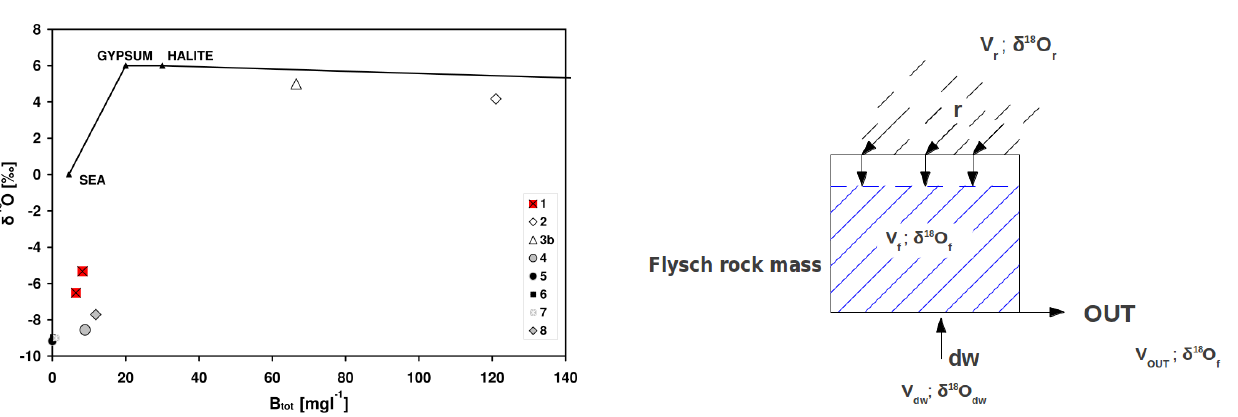
Fig. 9. B tot - δ 18 O diagram. Point: 2, 4 (Boschetti et al., 2010) – baths; 3b – mud volcanoes; 5 – common shallow groundwater; 6 (Cervi, 2003), 7 (Venturelli et al., 2003) – springs; 8 – hydrocarbon seep. Black line: evaporation line from seawater.